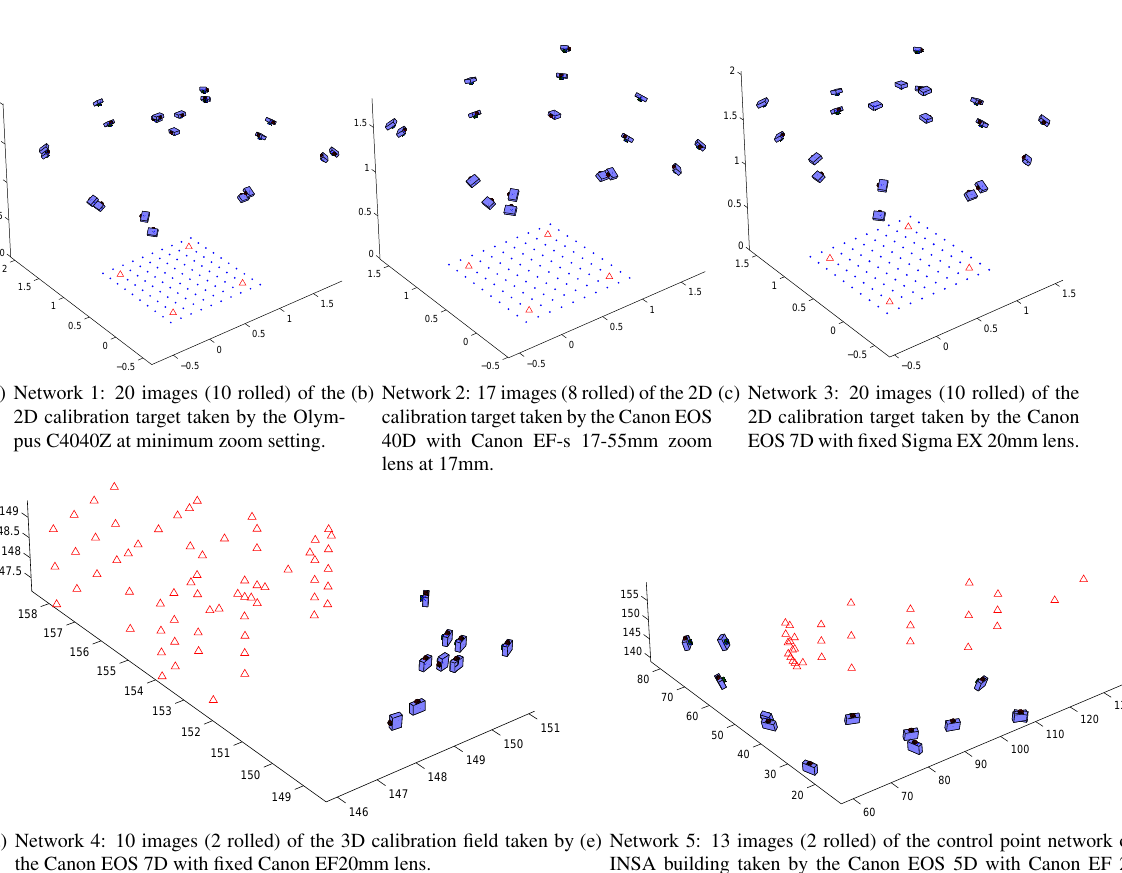
(e) Network 5: 13 images (2 rolled) of the control point network on the INSA building taken by the Canon EOS 5D with Canon EF 20mm fixed lens.